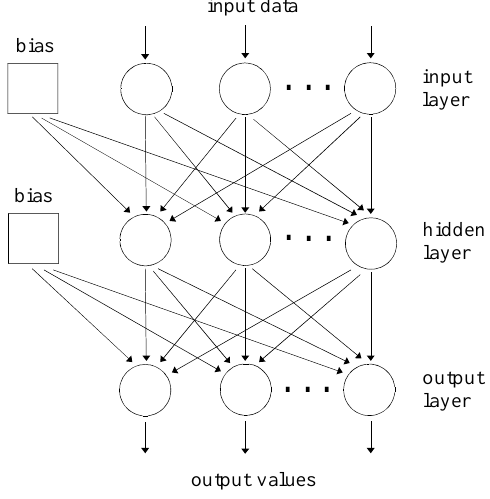
Fig. 3.1. Scheme of a three-layered, feedforward neural